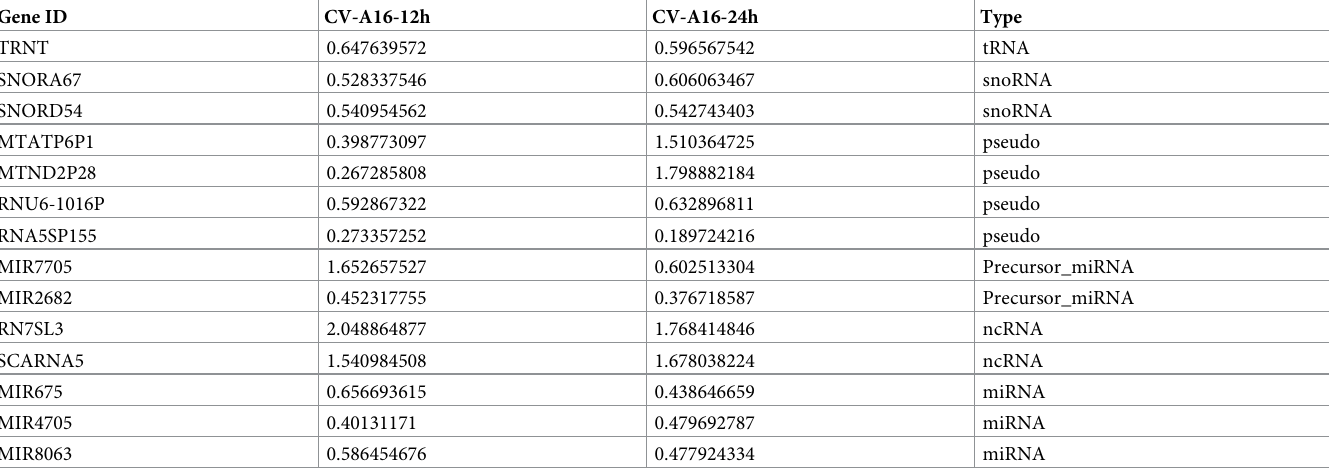
Table 4. Differentially expressed non-protein-coding genes simultaneously appeared in CV-A16-12h and CV-A16-24h. Gene